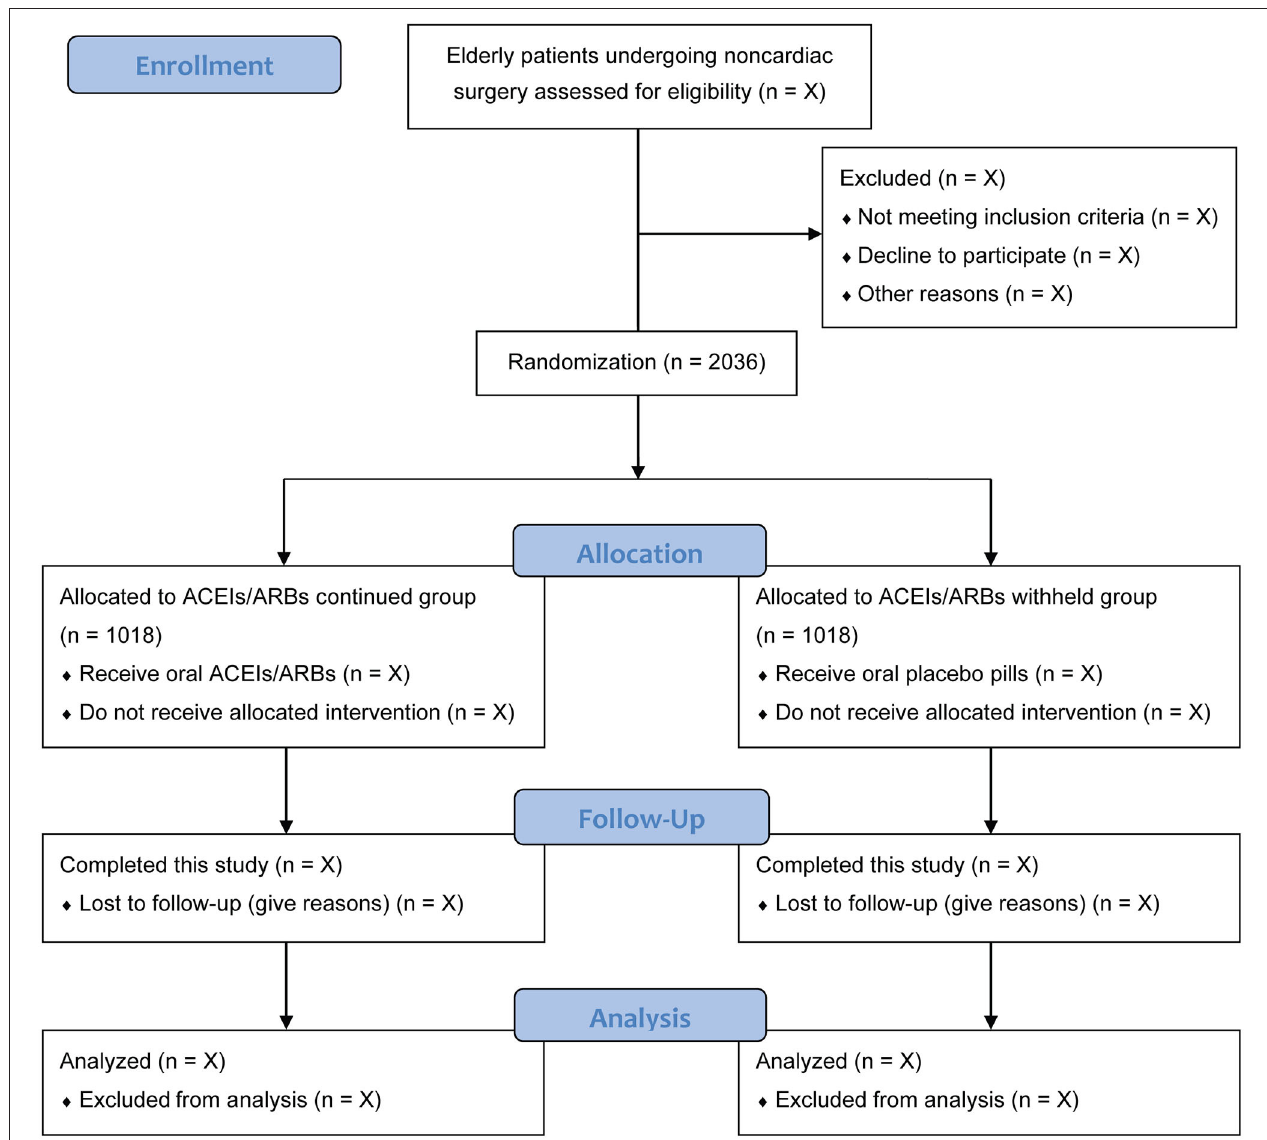
FIGURE 1 | Flow chart of participants. ACEIs/ARBs, angiotensin-converting enzyme inhibitors or angiotensin receptor